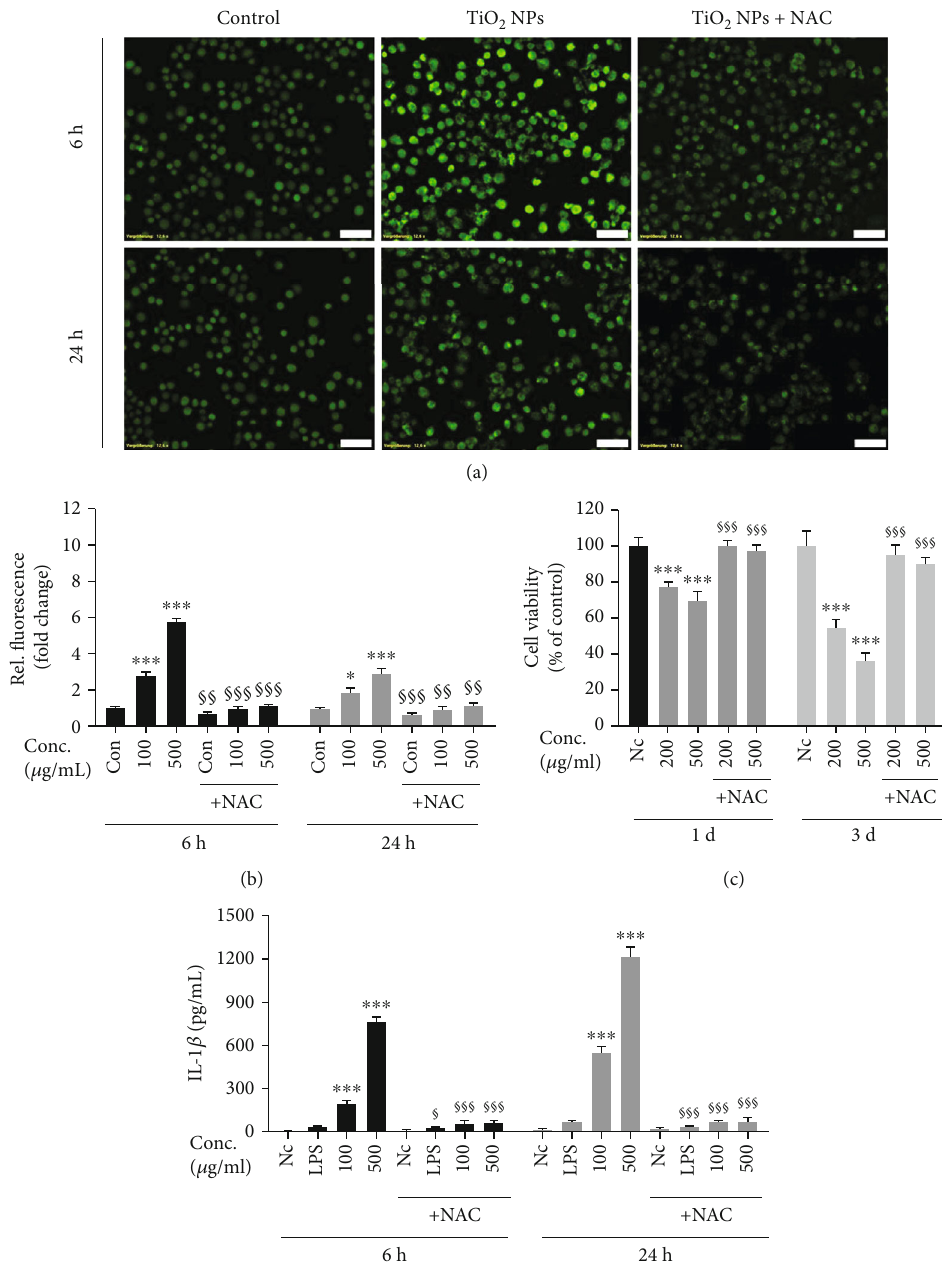
Figure 7: Protective role of ROS scavenger (NAC) on TiO NP-induced cell death and IL-1 β release. LPS-primed macrophages were 2 preincubated for 30min with/without NAC (5mM), and then cotreated with TiO NPs at the indicated doses for 6 and 24h. (a) Following 2 exposure, cells were incubated with DCFH-DA (20 μ M) for 30 min at 37 ° C, and ROS production was detected by fl uorescence microscopy (20x). Scale bar: 50 μ m. (b) Relative quanti fi cation of ROS generation (fold change). The protective role of NAC on (c) cell viability and release of (d) IL-1 β were measured by CCK-8 and ELISA, respectively. Data are presented as mean + SD of three identical experiments performed in three replicates. ∗ indicates signi fi cant di ff erence as compared to the control ( ∗ p < 0 : 05 , ∗∗ p < 0 : 01 , and ∗∗∗ p < 0 : 001 ); § indicates signi fi cant inhibitory e ff ect of NAC on cell death and proin fl ammatory cytokine generation ( § p < 0 : 05 , §§ p < 0 : 01 , and §§§ p < 0 : 001